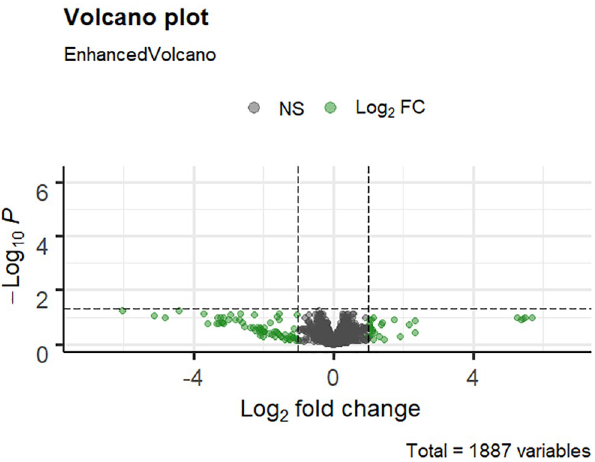
Fig 5. Volcano plot of Pennsylvania SEE RNA-Seq genes counts. The log 2 fold-change (logFC) is represented along the x-axis, and the log 10 -transformed false discovery rate (FDR) is represented along the y-axis. Gray points represent genes that were not identified as significantly differentially expressed (FDR � 0.05), and green points represent genes whose expression had a logFC � -1 or � 1. No genes met the criteria for interest of having an FDR � 0.05 and a logFC � -1 or �